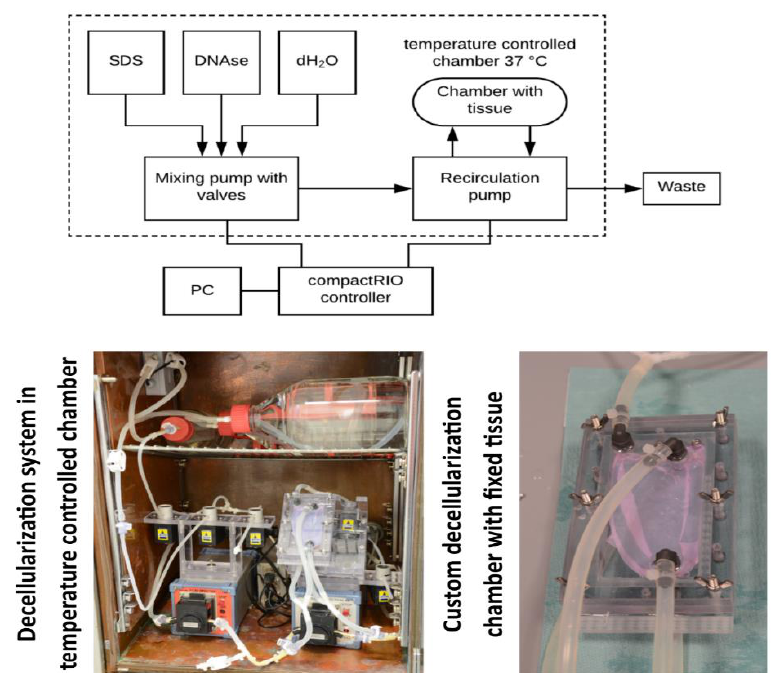
Figure 1. Schematic image of the decellularization system (top) and its installation in a temperature-controlled chamber (bottom left). Custom chamber for fixing pericardium and for maintaining the optimal process parameters (bottom right). The tissue is fixed in the chamber using a 4—0 suture on a silicone holder.